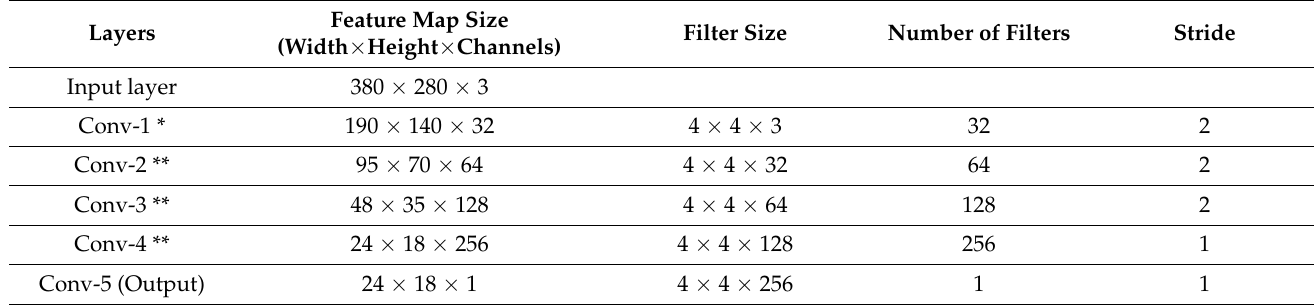
Table 3. Discriminator of OSRCycleGAN (#filter and S mean the number of filters and strides, respectively) (* and ** means that the Leaky ReLU (LReLU) and BN + LReLU combination are applied after the Conv, respectively. ReLU, BN, and Conv mean rectified linear unit, batch normalization, and convolution layer,